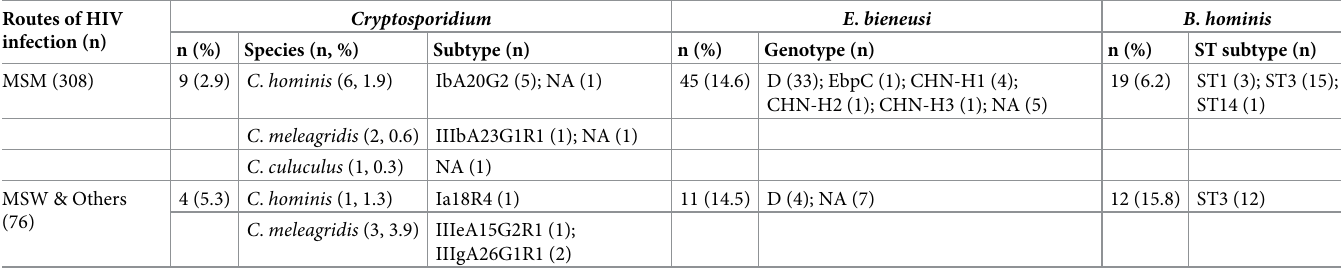
transmission routes were included. NA = not available.